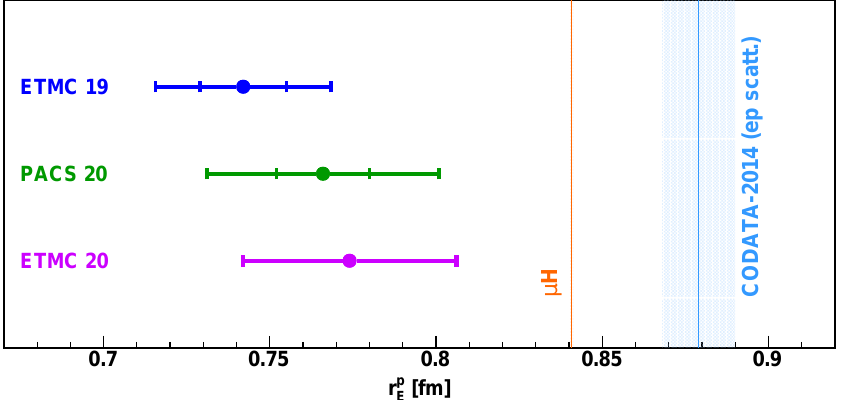
Figure 7. The proton charge radius r p from recent lattice QCD calculations [47,49,50], and compared to E the µ H measurement [20] and the CODATA-2014 recommended value [109]. ETMC 19 calculation [47] includes disconnected